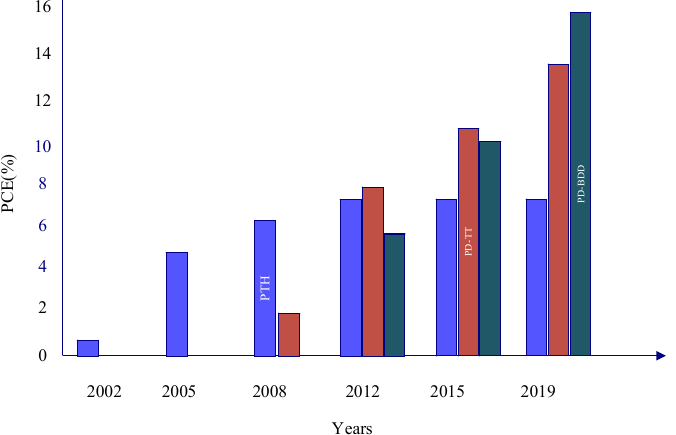
Figure 13. Research progress with regard to the efficiency enhancement for different kinds of OPV systems (Polythiophene (PTh), Poly electron-donating unit-thieno-thiophene (PD-TT) and Benzo- dithiophene-dione (PD-BDD)) from 2001–2019 [65].